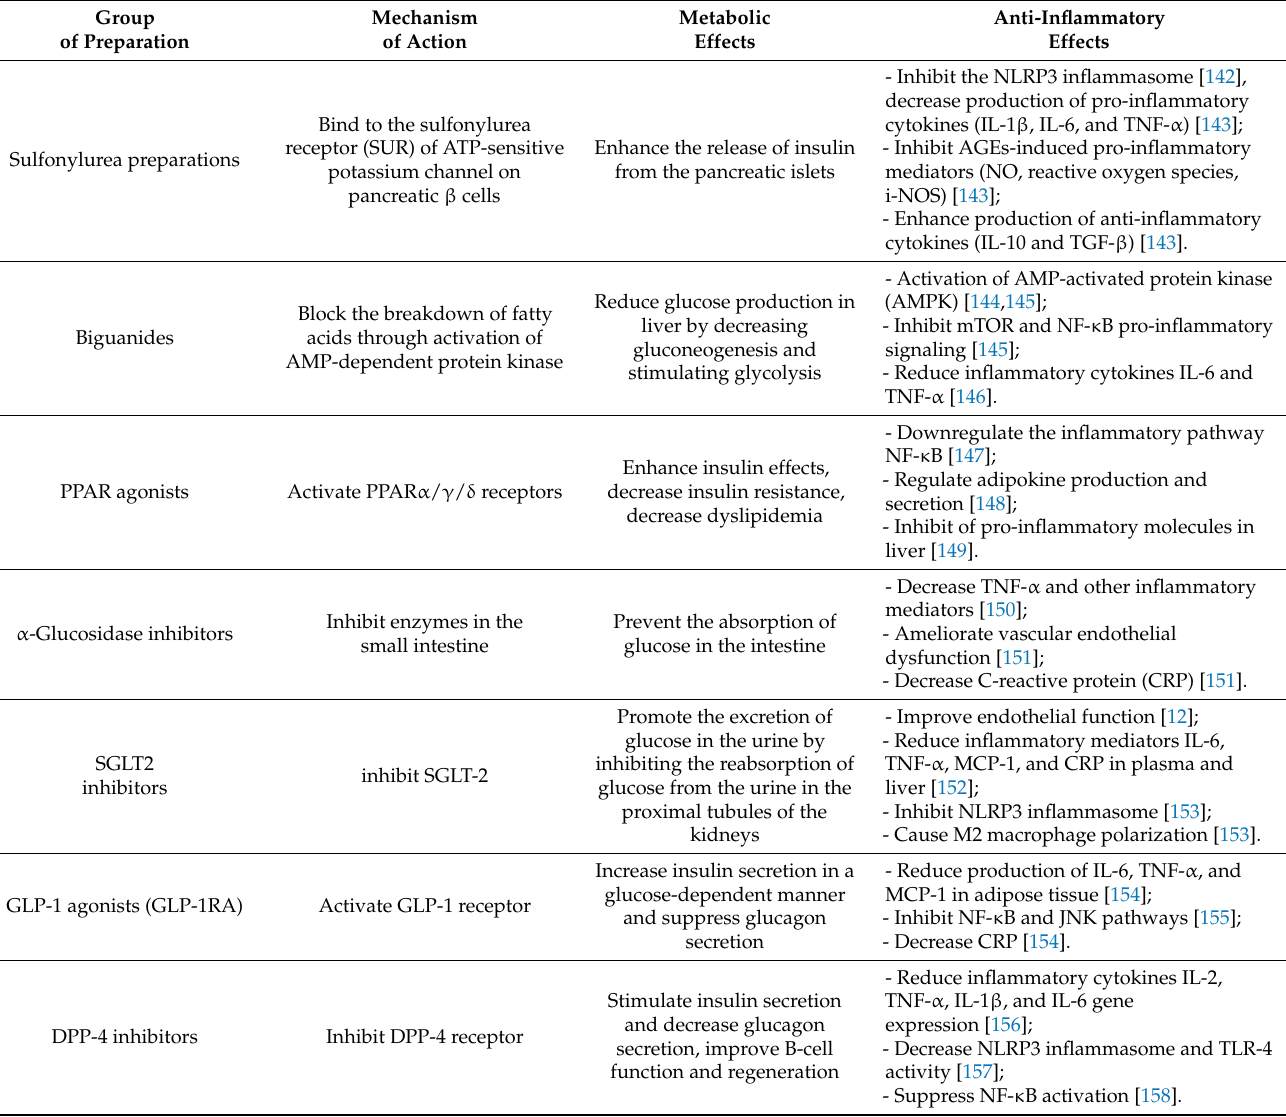
Table 2. Metabolic and anti-inflammatory effects of modern antidiabetic